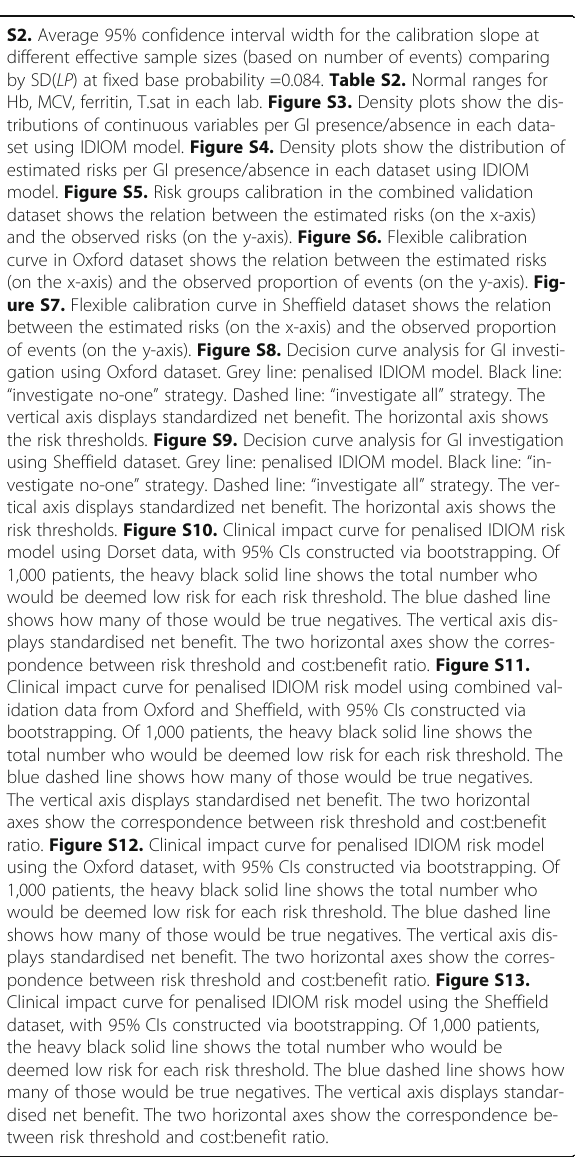
S2. Average 95% confidence interval width for the calibration slope at different effective sample sizes (based on number of events) comparing by SD( LP ) at fixed base probability =0.084. Table S2. Normal ranges for Hb, MCV, ferritin, T.sat in each lab. Figure S3. Density plots show the dis-